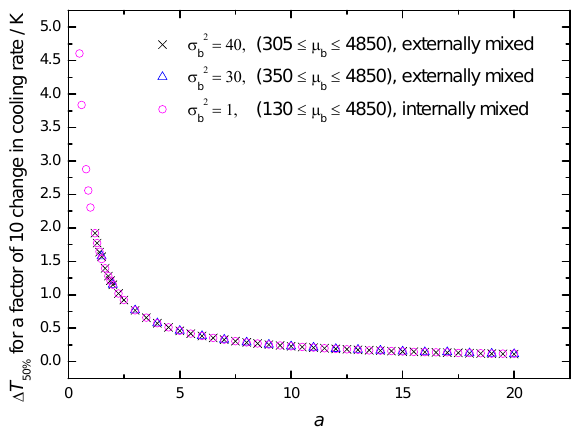
Fig. 10. The cooling rate dependence of freezing temperature on the parameter a (dln J /d T ) . Cooling rate dependence is indicated by 1T 50 %, which is the change in median freezing temperature on a factor of 10 change in cooling rate. The dependence is insensitive to the choice of σ b and µ . The values shown in this graph were calculated for both externally and internally mixed